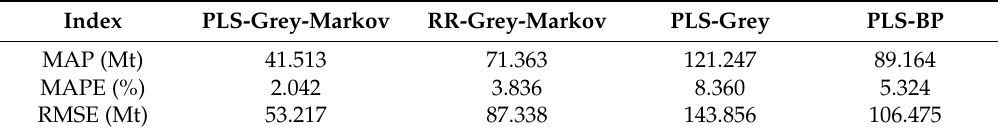
Table 8. The verifying results the rationality.